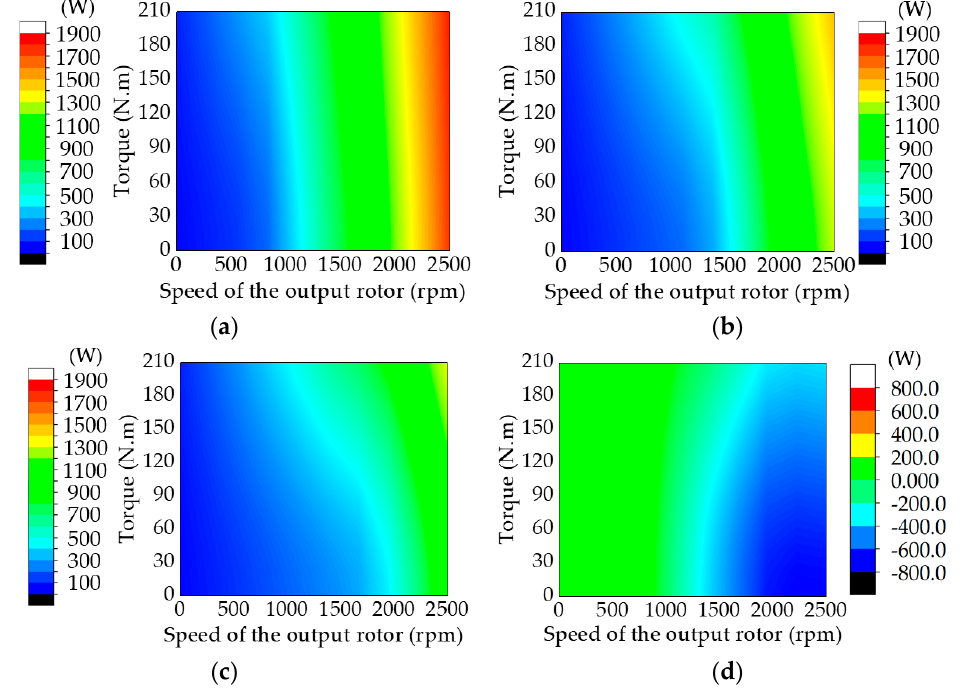
Figure 9. Iron loss map in the constant torque region according to the winding frequency when the amplitude of the outer winding current is adjusted and the inner winding current is fixed at the rated current (424 Arms). ( a ) Type I ( f inner 360 Hz and f outer 180 Hz); ( b ) Type II ( f inner 270 Hz and f outer 270 Hz); ( c ) Type III ( f inner 180 Hz and f outer 360 Hz); ( d ) Difference between Type III and Type I.